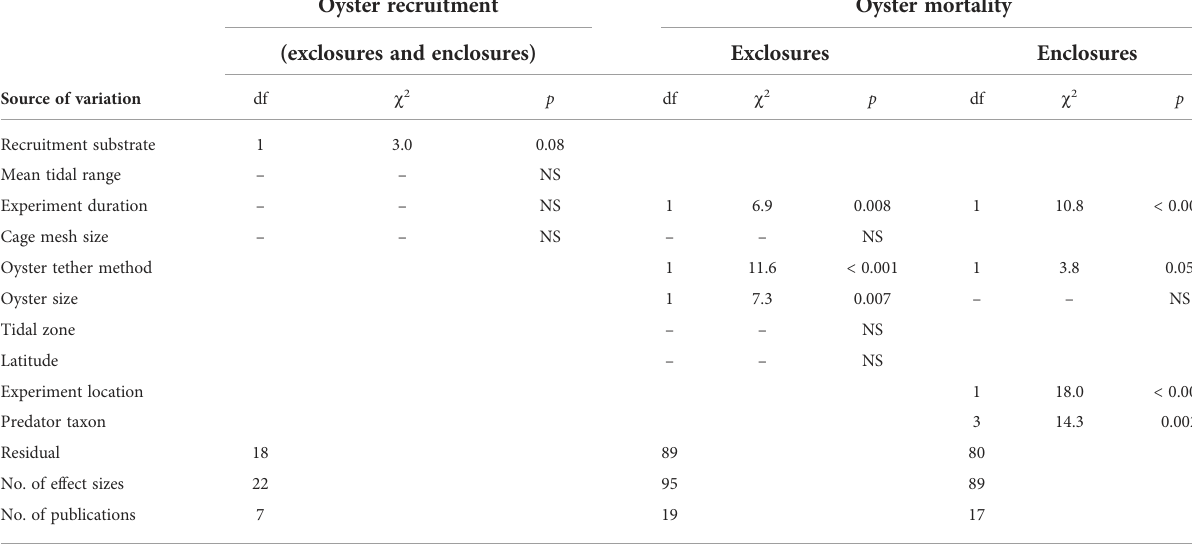
TABLE 2 Results of the linear mixed-effect models organized by response variable and experiment type. Oyster recruitment Oyster mortality (exclosures and enclosures) Exclosures